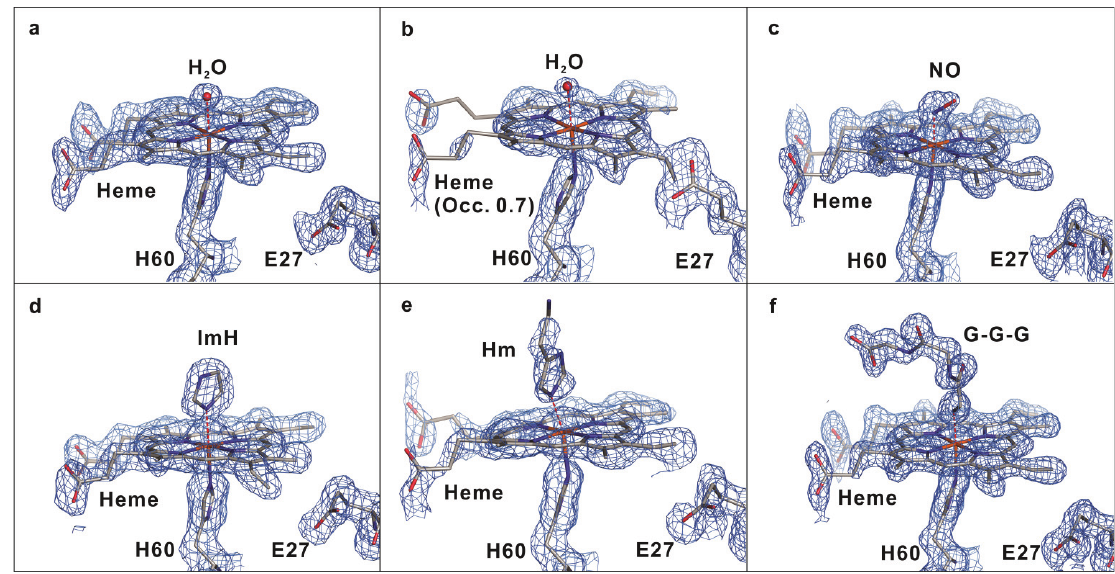
Figure 4. Electron density maps in ligand-bound NP7. 2Fo-Fc electron density map (contoured at 1 σ ) of the heme pocket of ( a ) NP7 at pH 5.8, ( b ) NP7 at pH 7.8, ( c ) NP7[NO], ( d ) NP7[ImH], ( e ) NP7[Hm], and ( f ) NP7[Gly-Gly-Gly].